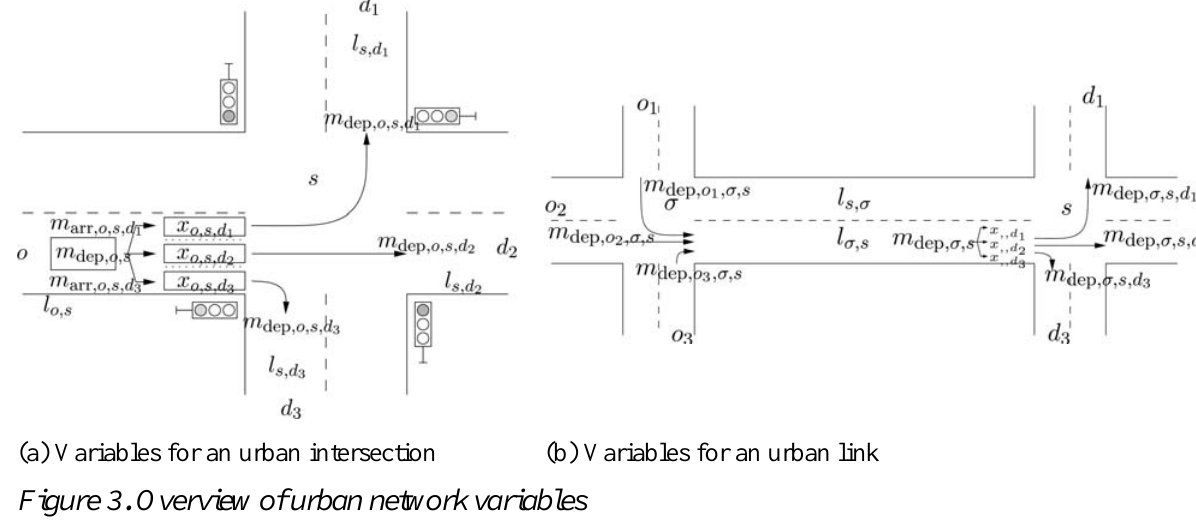
Figure 3. Overview of urban network